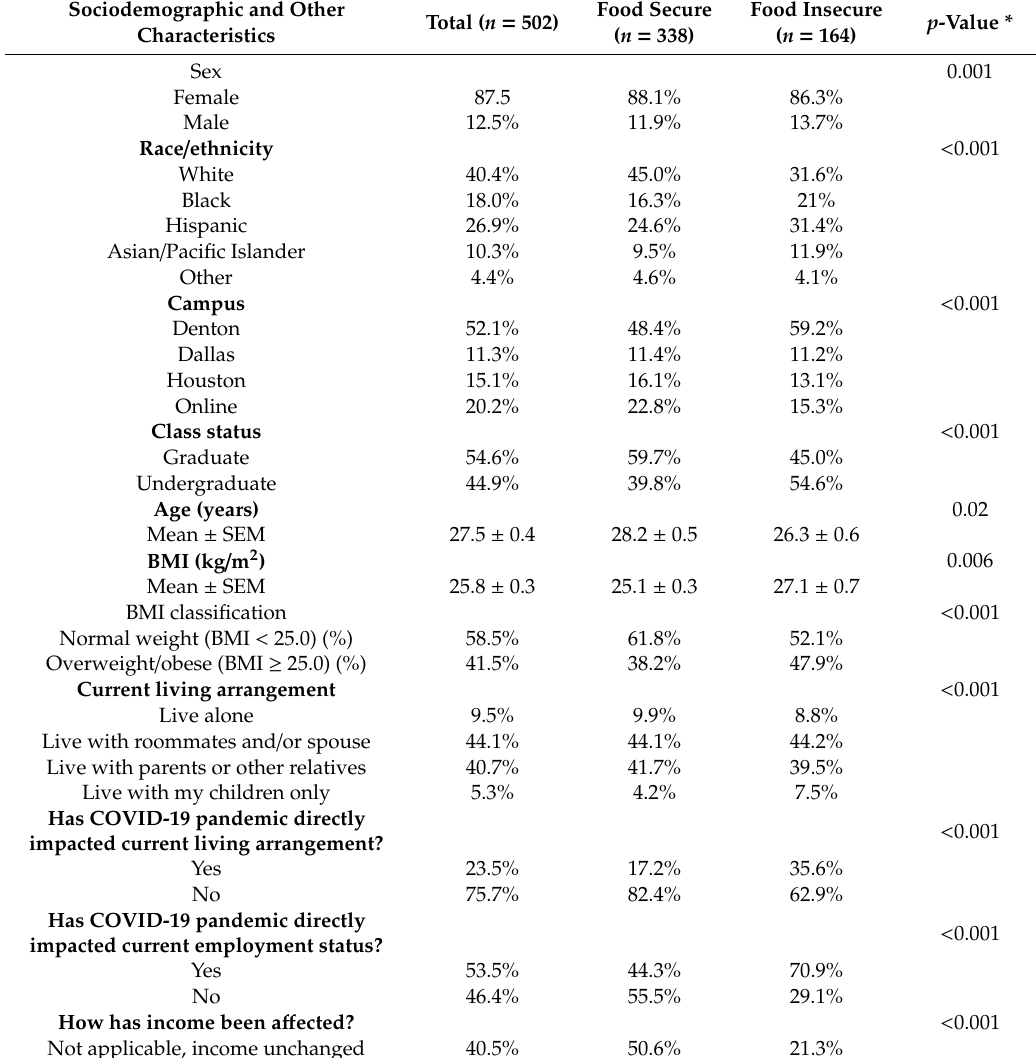
Table 4. Food security status (secure or insecure) according to sociodemographic characteristics, BMI, change in living status, and change in employment caused by the COVID-19